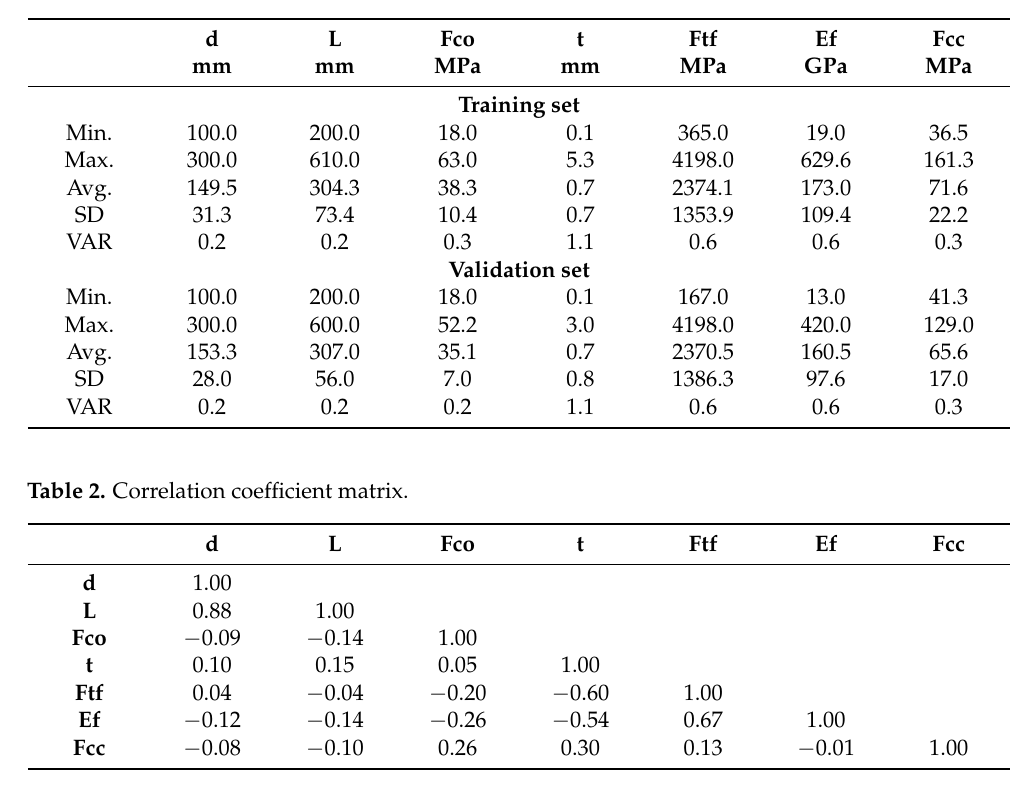
Table 1. Summary of statistical analysis results.